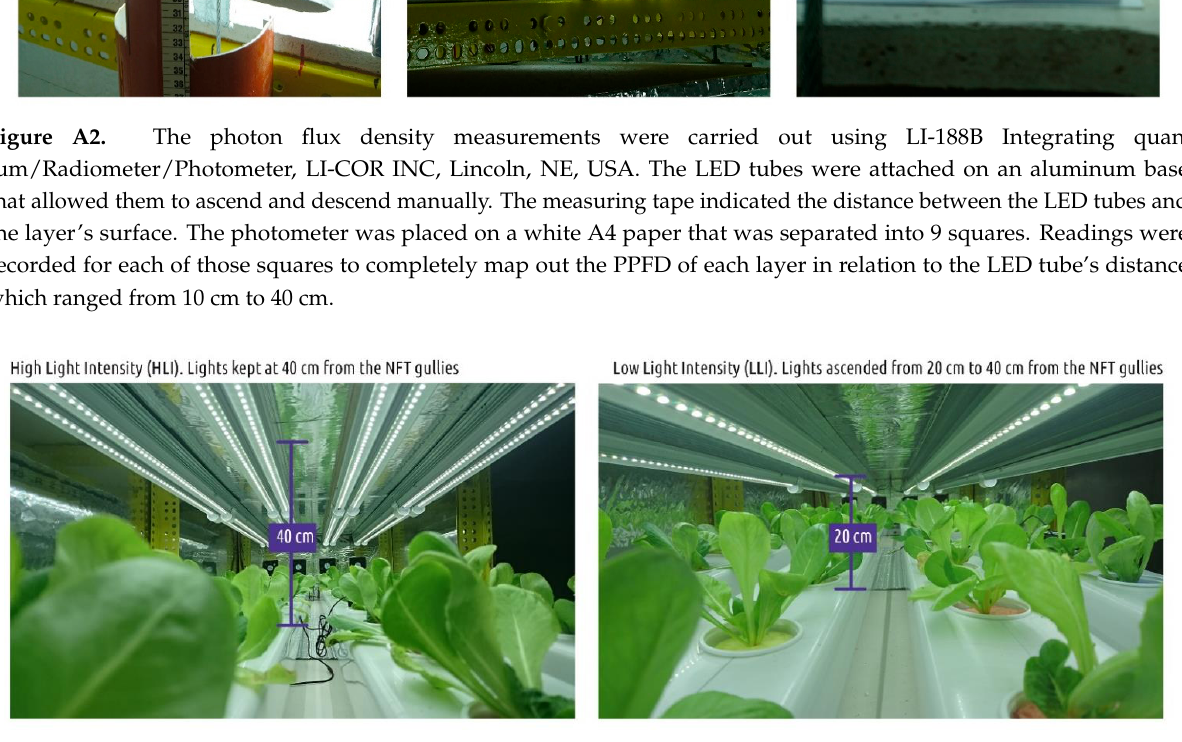
Figure A3. The LED tubes of the High Light Intensity treatment (HLI) were stationary. The distance between the NFT gullies and the LED tubes was 40 cm. The distance between the plant canopy and LED tubes was decreased as the planτs grew due to their increase in height, unlike in the LLI treatment were the LED tubes ascended from 20 cm to 40 cm distance from the NFT gullies as the plants grew, until the point the reached the ceiling of the